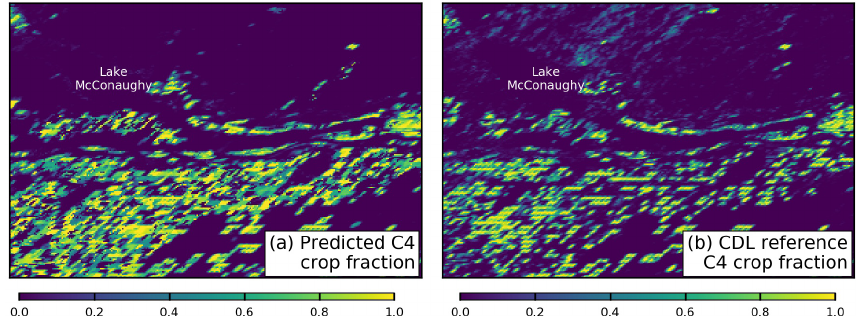
Figure 8. C4 crop fraction of (a) SLOPE predicted and (b) CDL reference data in a 50 × 75km 2 area in Keith County, Nebraska (red marker in Fig. 7a), in 2000. Only CDL data during 2008–2019 are used in the modeling procedure, and therefore (b) is independent of (a) . The maps are shown with the sinusoidal projection.